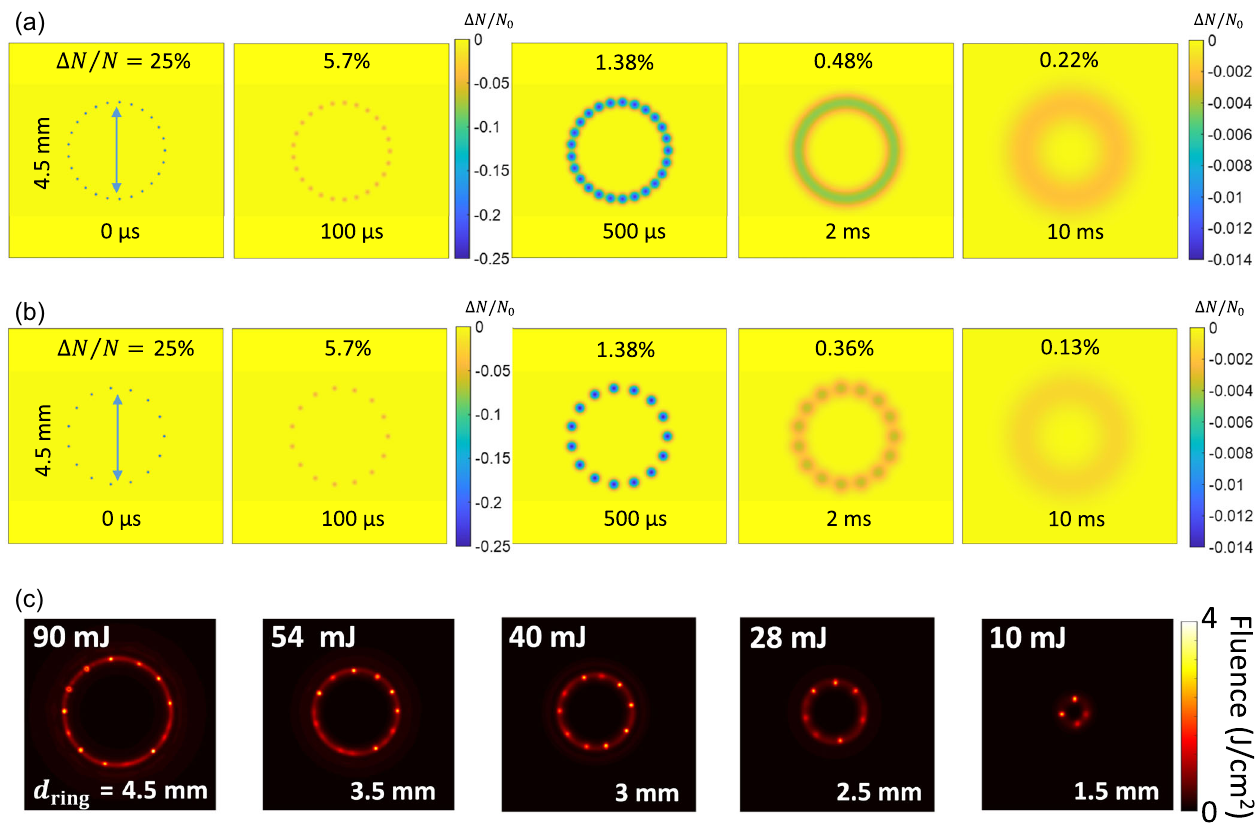
FIG. 1. (a) Thermal response of air to a ring array of 25 filament-initiated density holes of initial depth j Δ N j =N ¼ 0 . 25 and peak temperature increase Δ T ¼ 100 K. With increasing delay, the density holes merge by thermal diffusion to form a nearly continuous cladding moat around the central unperturbed air density core. (b) Same as (a), except for 15 filament-initiated density holes. (c) 3 D þ 1 YAPPE propagation simulation (see the Appendix) of the onset of filamentation of 100-fs LG 01 pulses of varying diameter and energy for constant initial peak fluence F 0 ¼ 0 . 21 J = cm 2 . The LG 01 pulses were initialized using a white-noise amplitude mask with fluence standard deviation 0 . 01 F 0 to seed filament